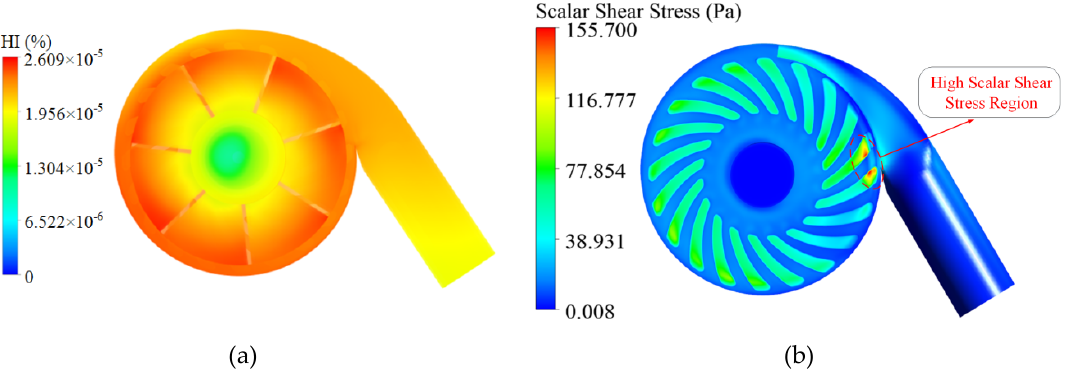
Figure 13. ( a ) HI distribution of the sinusoidal speed pattern at 0.9 s. ( b ) High shear stress region of the spiral groove in the sinusoidal speed pattern at 0.9 s.